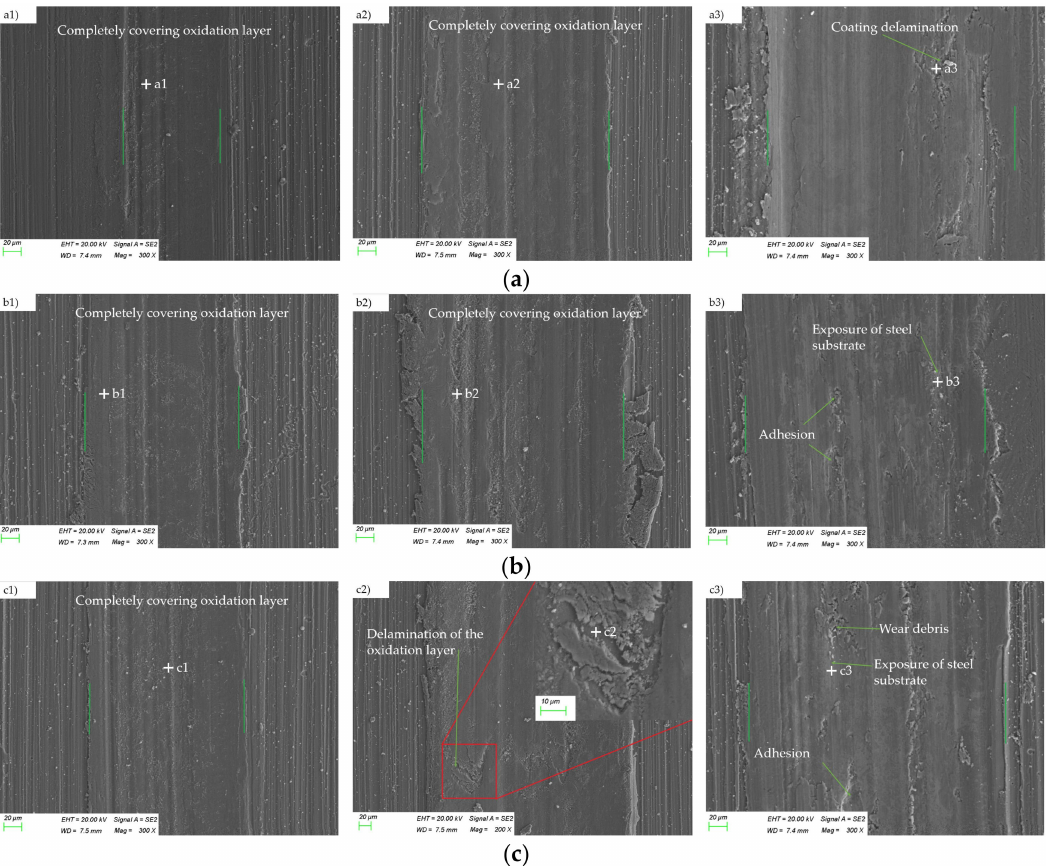
Figure 11. Morphology of the worn surfaces of 2 µ m CrN coated M50 disks: ( a ) at the temperature of 315 ◦ C under the load of ( a1 ) 10 N, ( a2 ) 15 N, and ( a3 ) 25 N; ( b ) at the temperature of 400 ◦ C under the load of ( b1 ) 10 N, ( b2 ) 15 N, and ( b3 ) 25 N; and ( c ) at the temperature of 500 ◦ C under the load of ( c1 ) 10 N, ( c2 ) 15 N, and ( c3 ) 25 N.